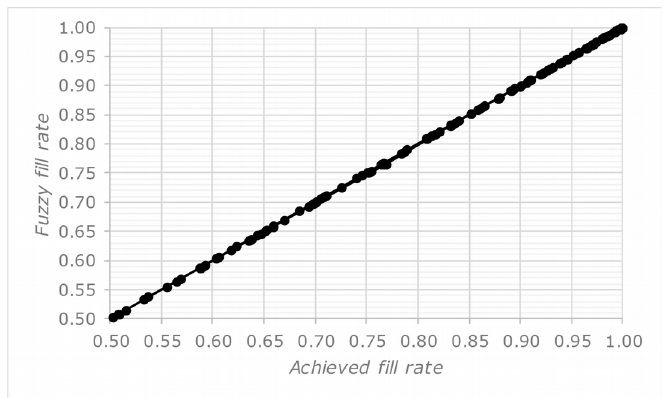
Figure 3. Fuzzy versus achieved fill rate scatter